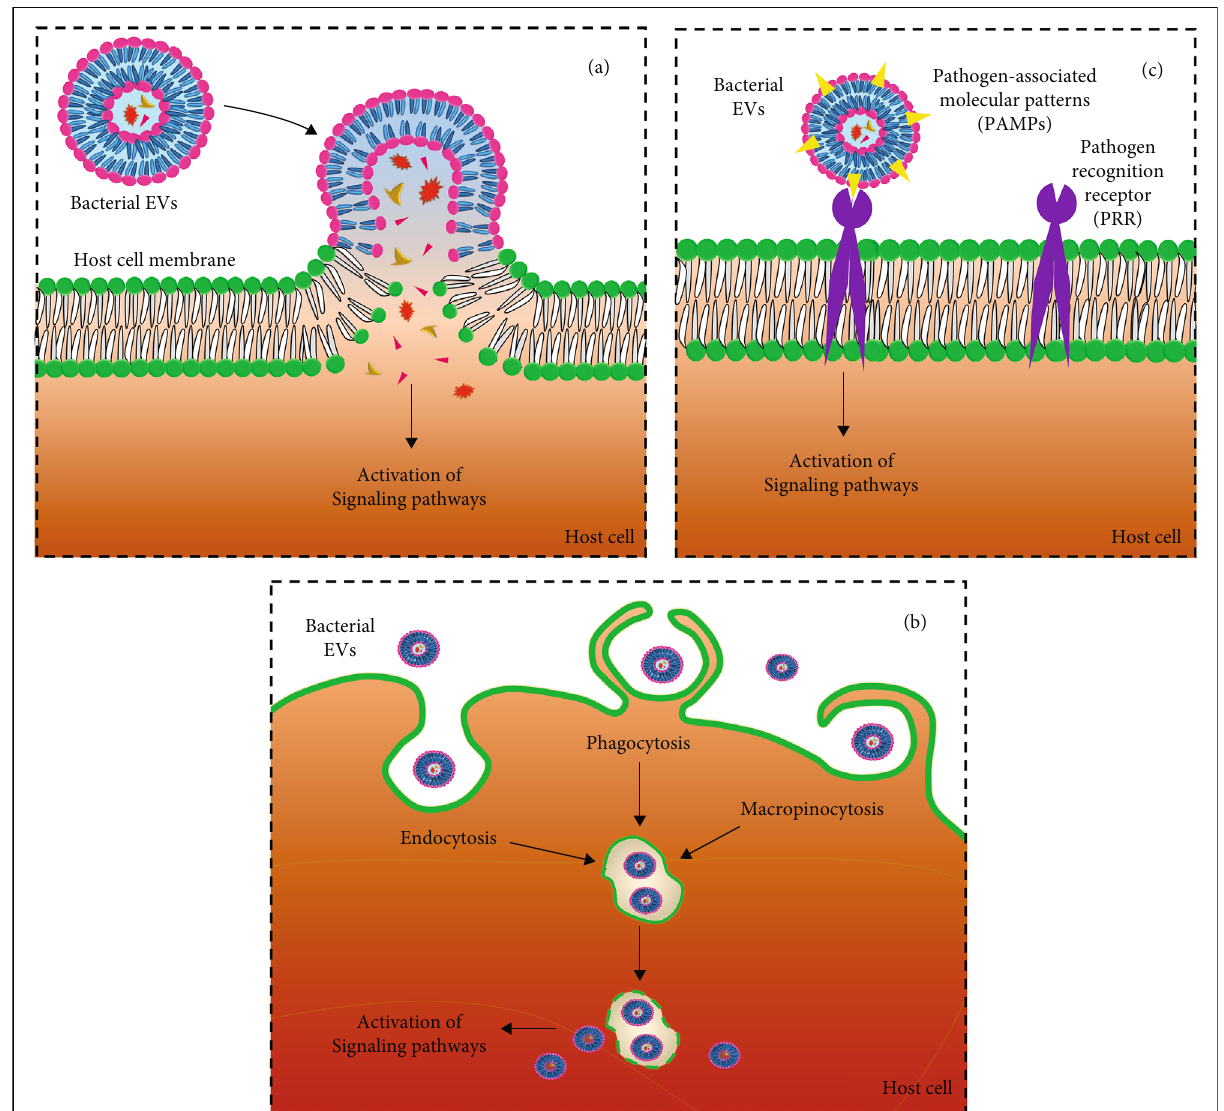
Figure 2: Three main mechanisms of EV uptake by host cells in schematic. (a) Delivery of bacterial EV contents into the host cell by direct membrane fusion or lipid rafts. (b) Direct entrance of bacterial EVs by endocytosis, phagocytosis, or micropinocytosis. (c) Ligand-receptor interaction. The order of mechanisms is in parallel to Figure